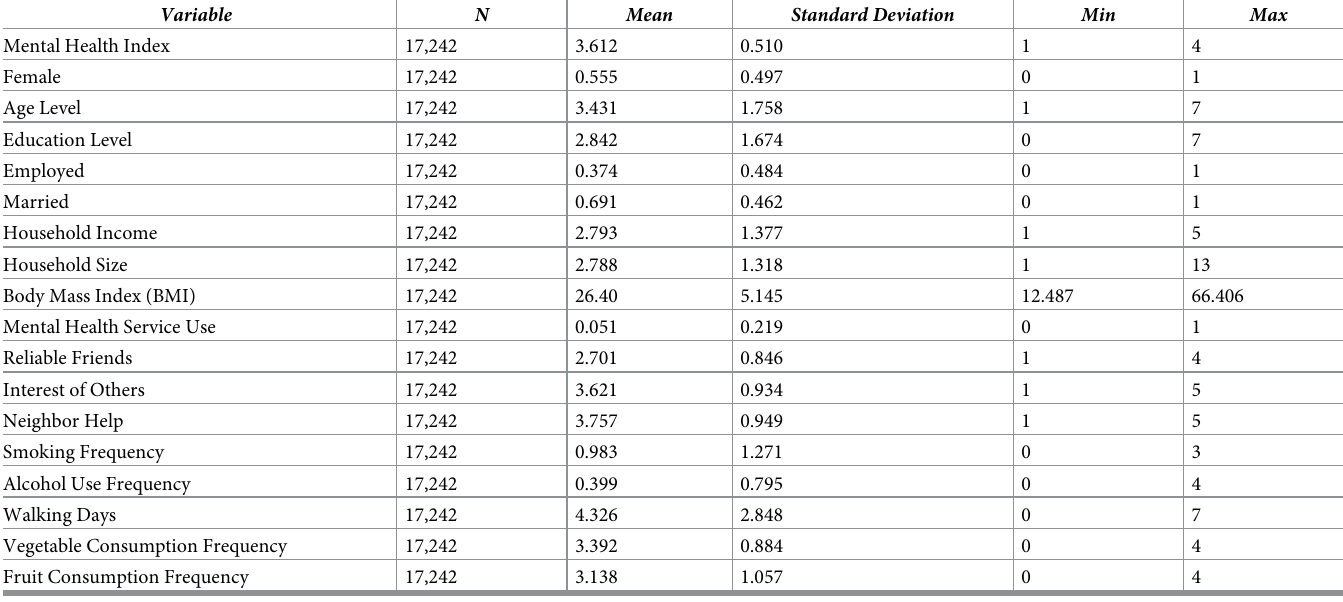
Table 3. Summary